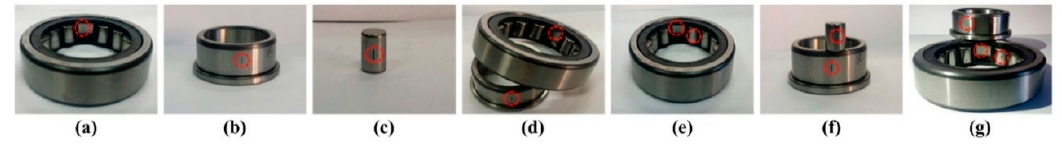
Figure 5. Single and compound bearing faults: ( a ) outer race defect (ORD); ( b ) inner race defect (IRD); ( c ) roller defect (RD); ( d ) inner and outer race defect (IORD); ( e ) outer race and roller defect (ORRD); ( f ) inner race and roller (IRRD); ( g ) inner race, outer race, and roller (IORRD). The data acquisition system consists of a wideband AE sensor attached to a non-drive-end